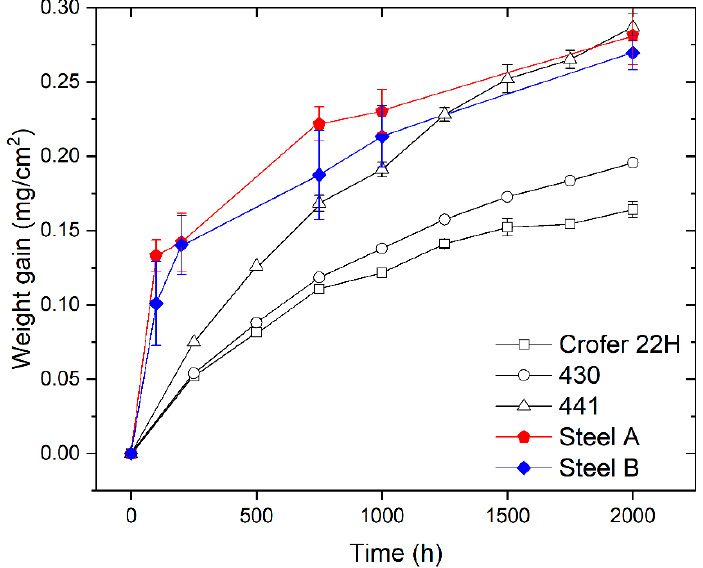
Figure 2. Comparison among weight gain data for Steel A and Steel B (experimental), and AISI 441, AISI 430, and Crofer 22H reprinted with permission from ref. [45], copyright 2021 Elsevier. All the measurements were carried out during oxidation in air at 750 °C.